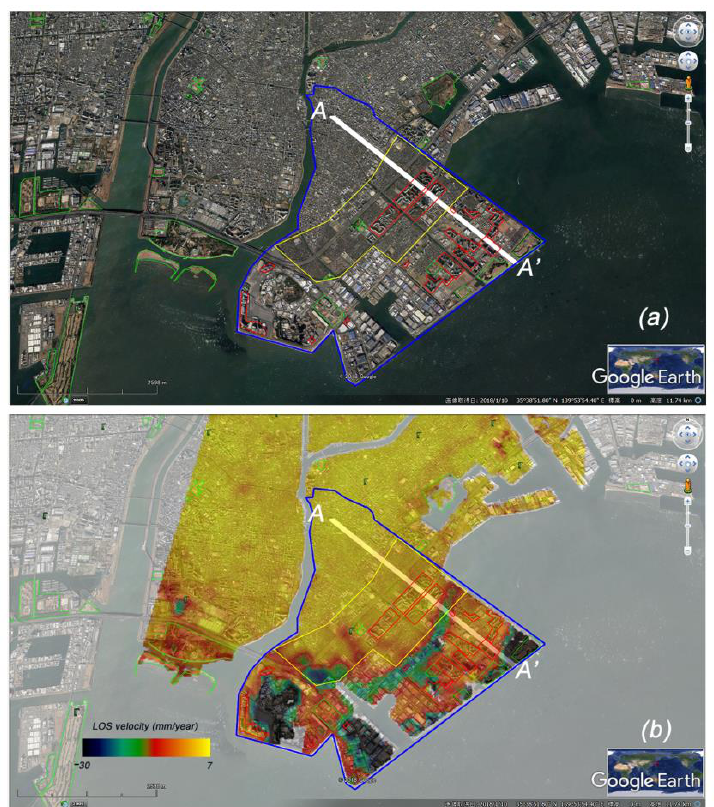
Figure 15. Subsidence rate map (2006–2010) generated with ALOS PALSAR data overlaid on a Google Earth image. The green polygons indicate the park area, red polygons indicate the location of high-rise buildings, the yellow polygon shows the highly populated residential area. The blue polygon indicates the border of Urayasu City and corresponds to the location of Figure 14a, and the A–A’ line corresponds to the soil cross section in Figure 14a and 14b.